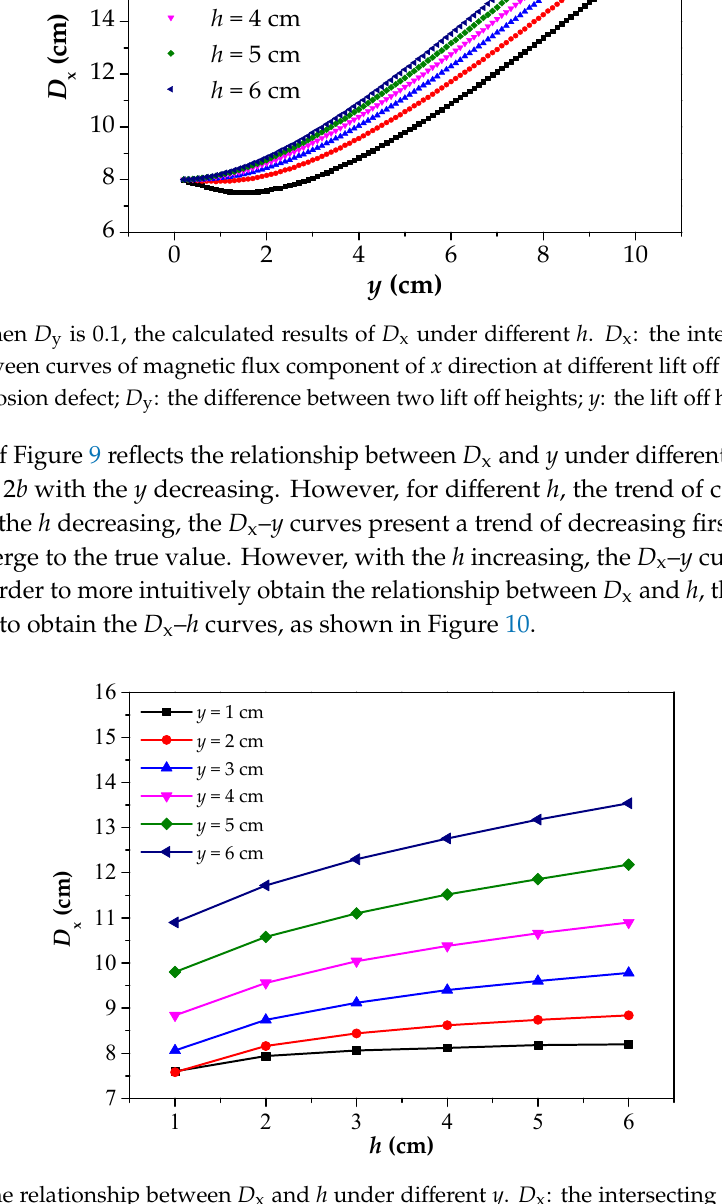
8 of 21 Figure 8. The calculated results of D x under the different values of h : ( a ) The calculated results of D x under h = 1 cm; ( b ) the calculated results of D x under h = 3 cm; ( c ) The calculated results of D x under h = 5 cm; D x : the intersecting point distance between curves of magnetic flux component of x direction at different lift off heights; y 1 and y 2 : the lift off height; h : the depth of corrosion defect. The image of Figure 9 reflects the relationship between D x and y under different h . In Figure 9,